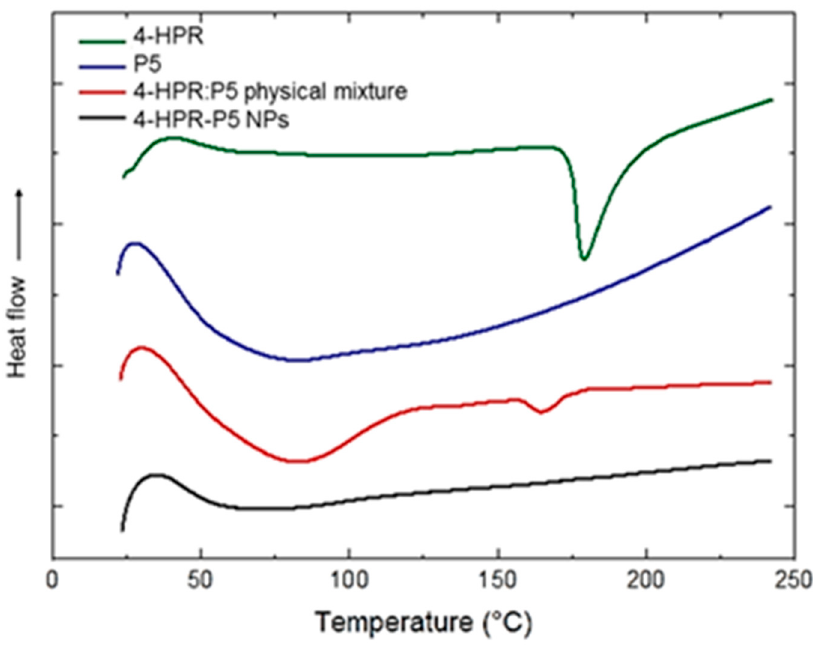
Figure 6. DSC thermograms of raw 4-HPR, P5, 4-HPR-P5 physical mixture, and 4-HPR-P5 NPs.